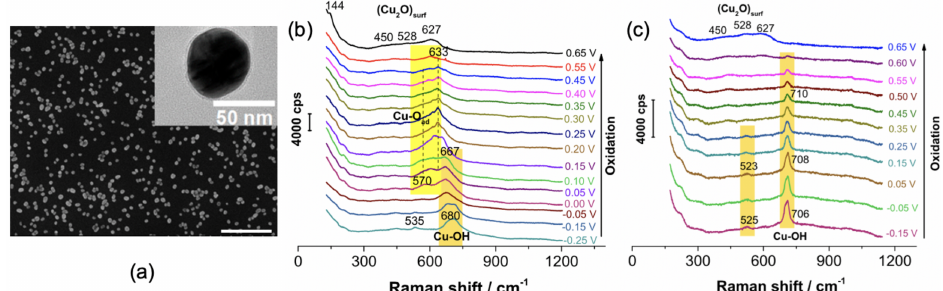
Figure 4. ( a ) SEM picture of Au@SiO 2 nanoparticles on Cu surface (scale bar = 1 µ m). The in- set displays a TEM picture of a Au@SiO 2 nanoparticle. ( b ) SHINERS spectra for Cu(111) oxida- tion in a 0.01 M KOH solution. ( c ) SHINERS spectra for Cu(poly) oxidation in a 0.01 M KOH solution. All the figures are reprinted (adapted) with permission from [94], Copyright 2019 American Chemical